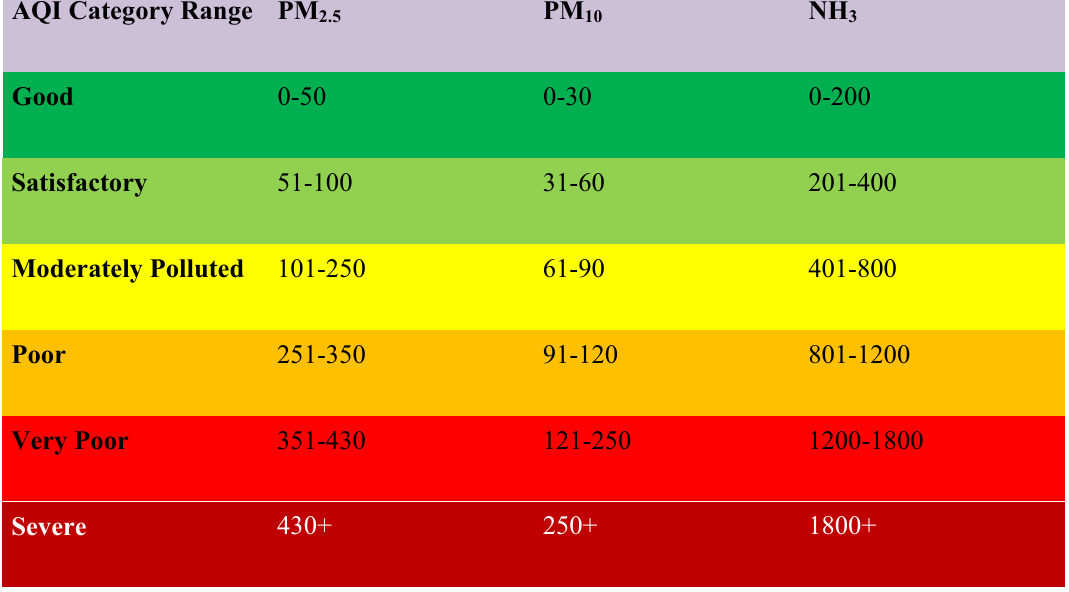
Table 1. Category range of AQI for considered pollutants as per National AQI, CPCB (2014) illustrating AQI categories advisable for human health in